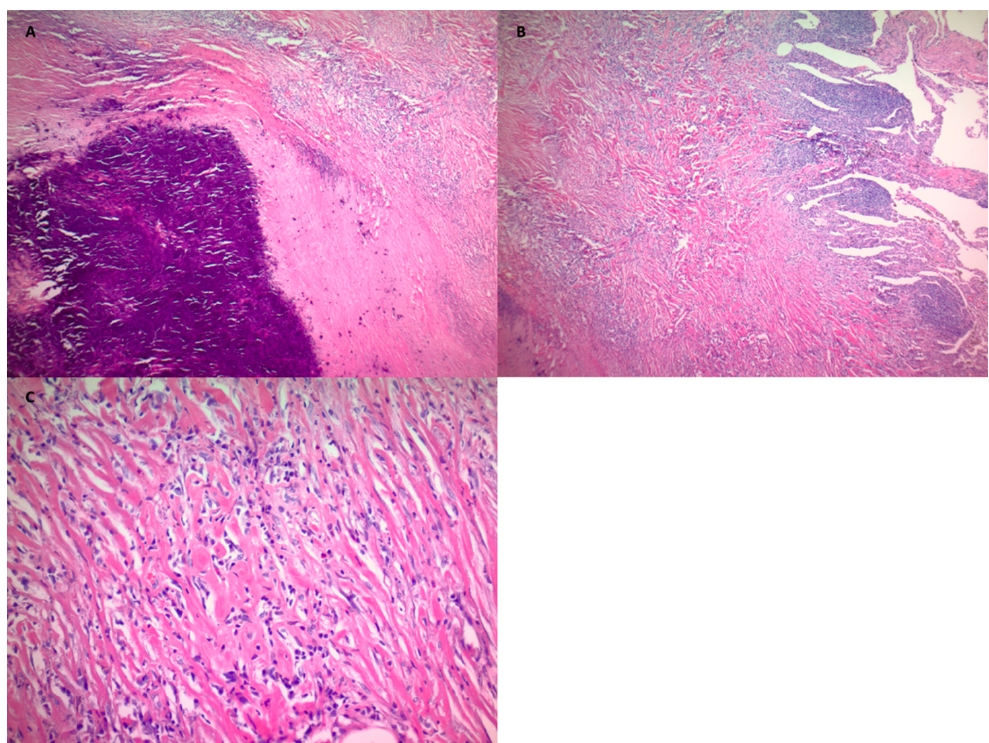
Figure 2. Is the histopathology of the resected mass from the left upper lobe showing dense network of hyalinized collagen and lymphocytic infiltrate ( A , B ). Collagen in lamellar pattern with whorls and surrounded by lymphocytic infiltrate ( C ) (Hematoxylin and Eosin staining, ( A ): × 40, ( B ): × 40, ( C ): × 400).